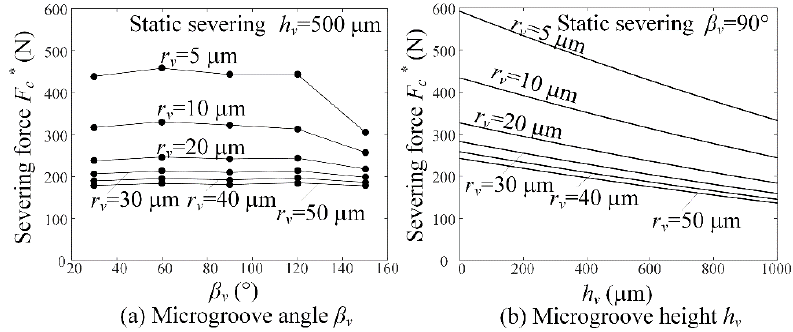
Figure 9. Ideal severing force F c* versus microgroove parameters: ( a ) microgroove angle β v and ( b ) microgroove height h v .